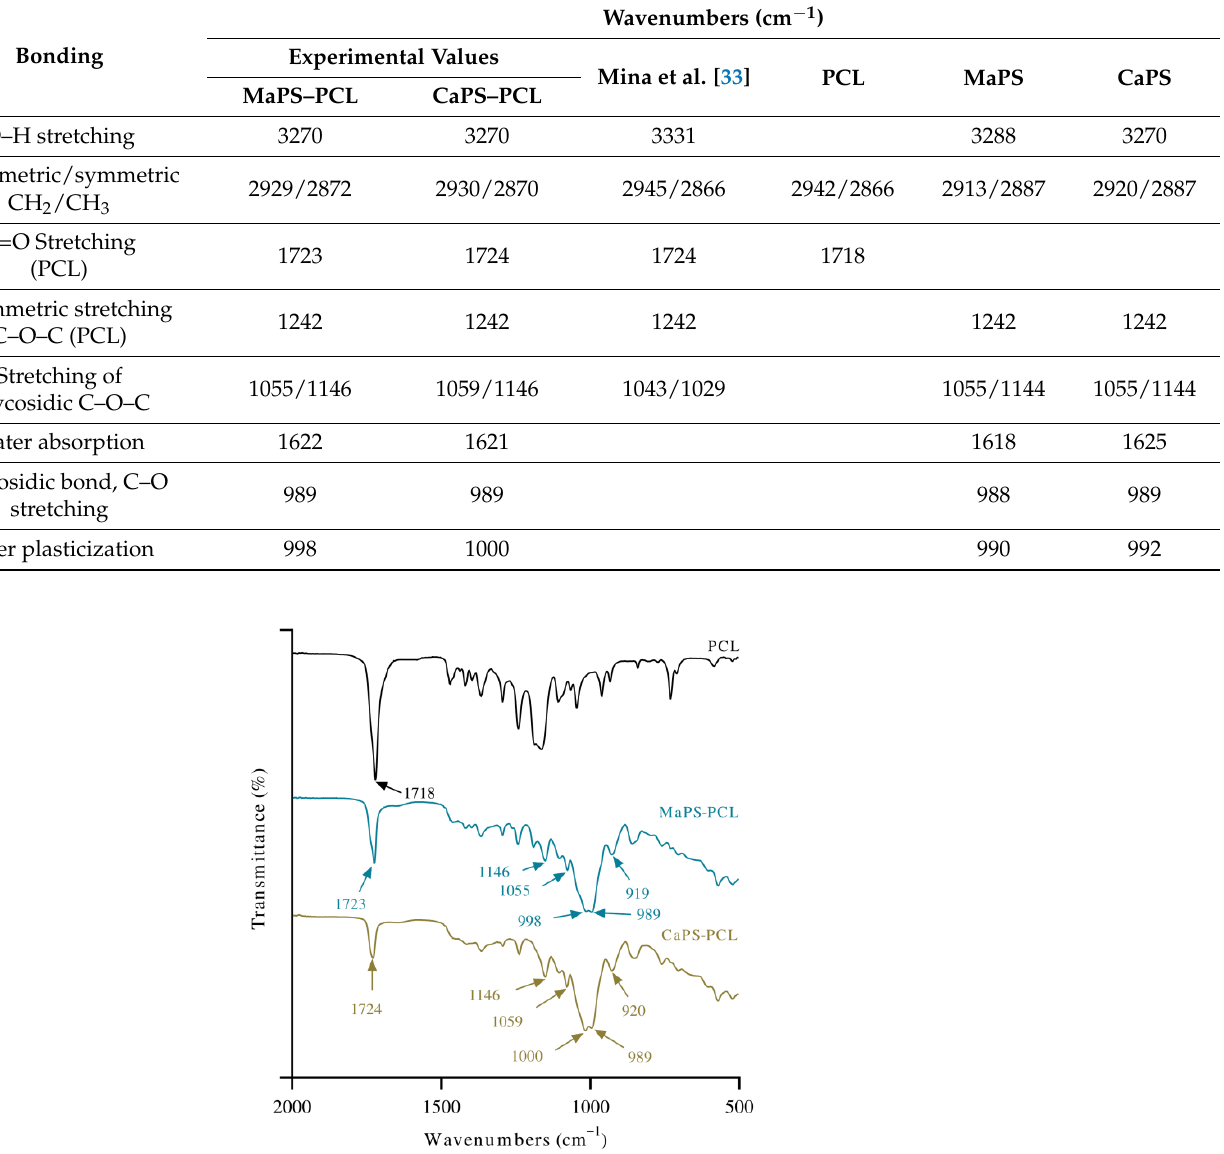
Table 1. Band assignation in the FTIR spectra.